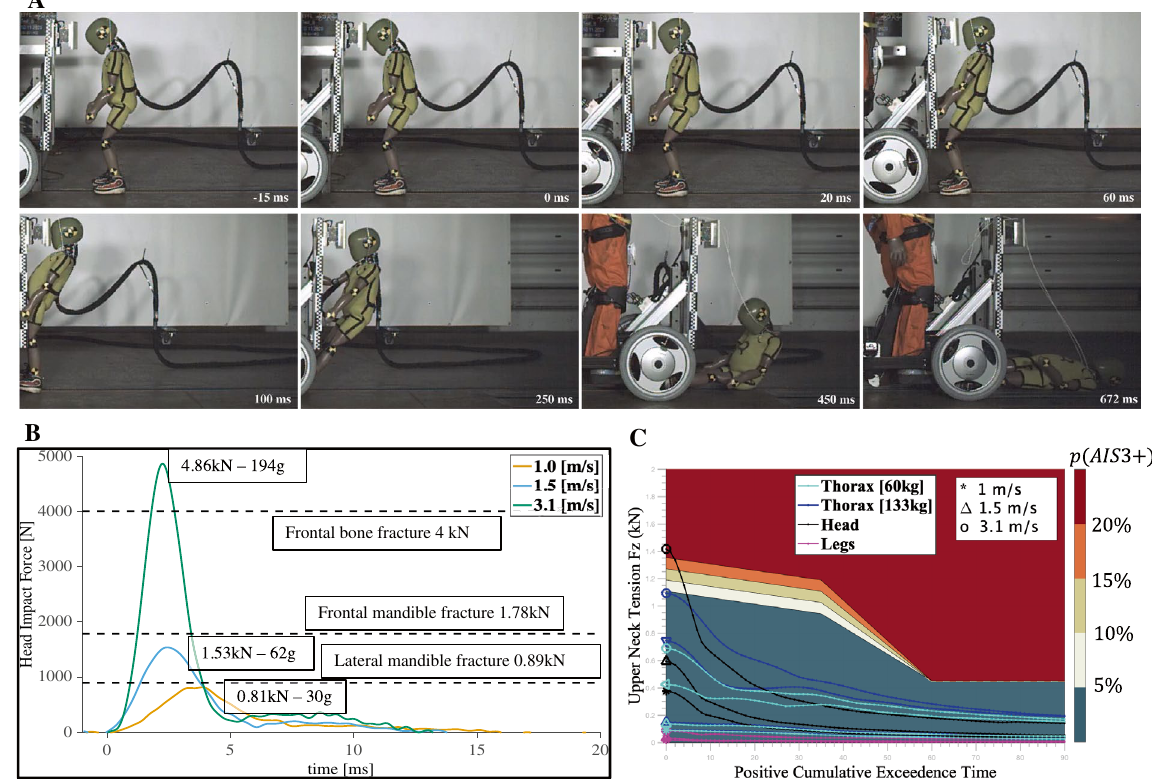
Figure 2. Child pedestrian injuries from a head impact. ( A ) Time-lapse of a mobile service robot (133 kg) impacting the head of a child dummy (2.7 kg). ( B ) Measured head-to-robot resultant force when varying the velocity at impact compared to reference results for bone fracture values from adult head impacts 53 . ( C ) Injury estimation at the neck of the child dummy based on exceedance of neck extension force under tension measured on the scale AIS3+ at all impact